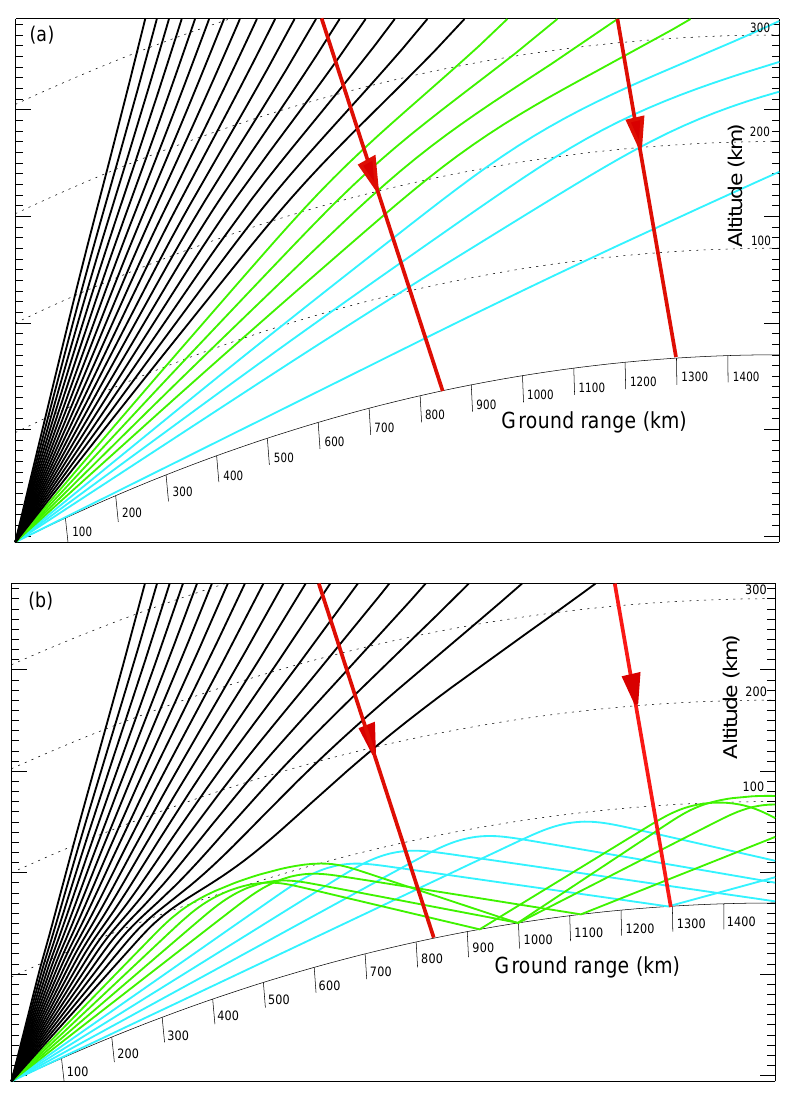
Fig. 8. A ray-tracing simulation of the HF propagation conditions for Hankasalmi (a) prior to the substorm expansion phase onset (based upon the ionospheric profile in Fig. 6a) and (b) during the substorm expansion phase (based upon the ionospheric profile in Fig. 6b). The geomagnetic field direction is indicated by the red lines. The changing HF propagation conditions affecting the HF rays indicated in black, blue and green are discussed in the